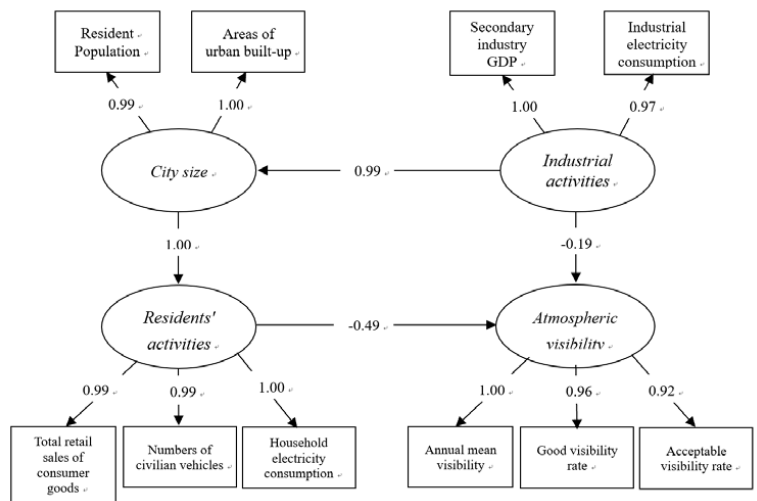
Figure 6. Standardized estimates of the modification model. The variables in the rectangles are the observed factors; the variables in the ellipses are the latent variables; the numbers on the arrows of the latent variables to the observed variables (latent variables) indicated the level of influence from the latent variable observed factors or the latent variables.